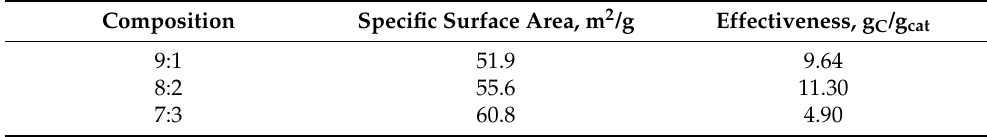
Table 3. Characteristics of Ni/MgO catalysts.